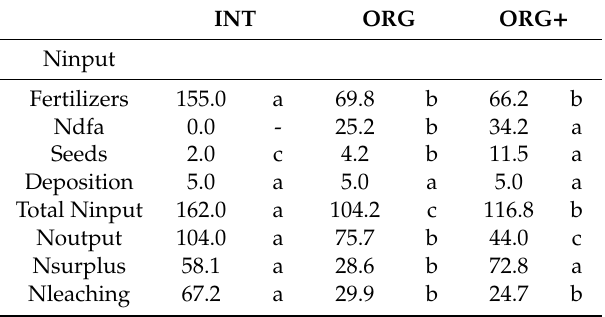
Table 1. Annual mean values (2-crop and 4-year basis, kg N ha − 1 yr − 1 ) of Nitrogen inputs (Ninput), outputs (Noutput), surplus (Nsurplus) and N lost by leaching (Nleaching) during the experiment for